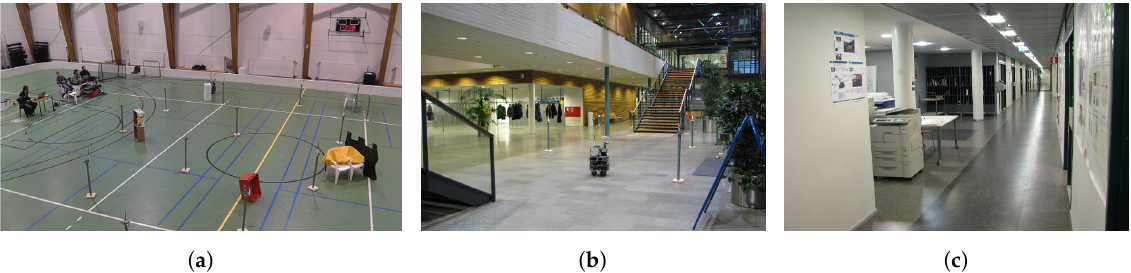
Figure 1. Environments of the experimental data collection campaign. ( a ) Basketball court; ( b ) lobby; ( c )